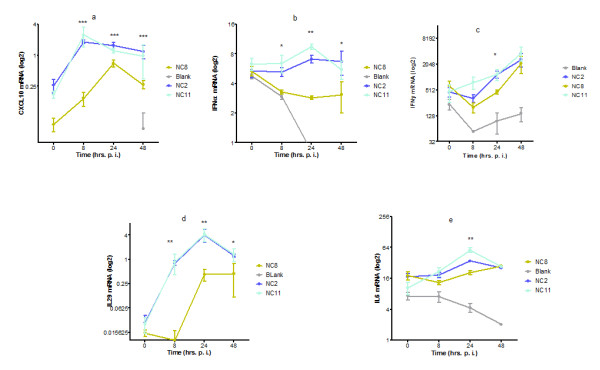
Comparison of infection with different strains of pdmH1N1 virus in A549 cells. The figure shows the comparative analysis of cellular immune mediators after NC2, NC8 and NC11 infection. Cells were infected with respective viral strains while mock infection with HBSS was given to blank. At different time points, mRNA expression of different cytokine/chemokine genes was measured by real time RT-PCR. Results are presented as log 2 of mean arbitrary units ± SEM. Data are compared by Mann Whitney U test. *** _P < 0.0001, **_ P <0.001, * _ P <0.01.